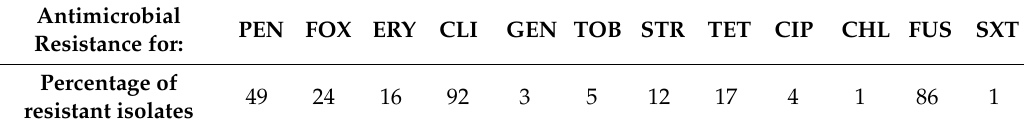
Table 2. Antimicrobial resistance rates detected among the CoNS isolates recovered from wild birds. Antimicrobial PEN FOX ERY CLI GEN TOB STR TET CIP CHL FUS SXT Resistance for: Percentage of 49 24 16 92 3 5 12 17 4 1 86 1 resistant isolates PEN, penicillin; FOX, cefoxitin; ERY, erythromycin; CLI, clindamycin; GEN, gentamicin; TOB, tobramycin; STR, streptomycin; TET, tetracycline; CIP, ciprofloxacin; CHL, chloramphenicol; FUS, fusidic